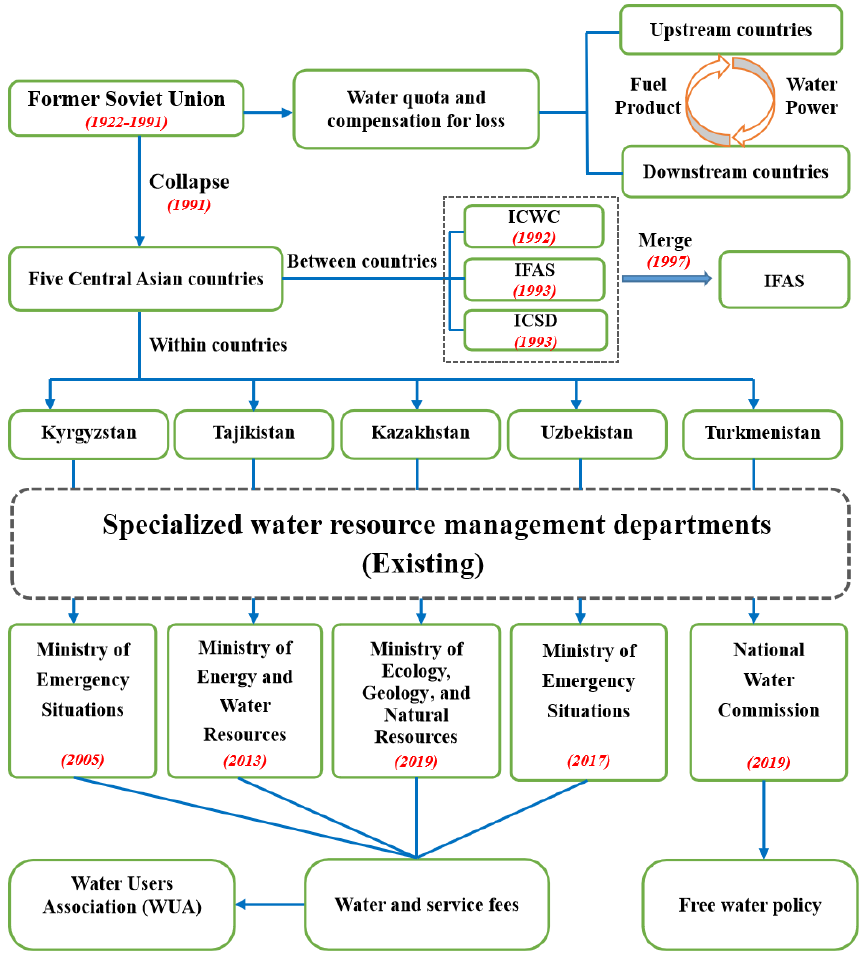
Figure 6. Evolution of water management policies and institutional framework in Central Asia. Note: the numbers in red are the years in which major institutional changes